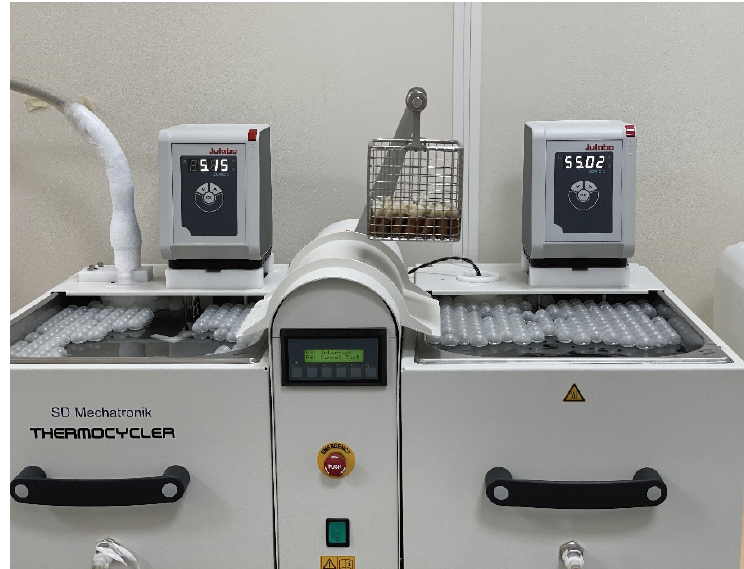
Figure 2. Thermocycling procedure.